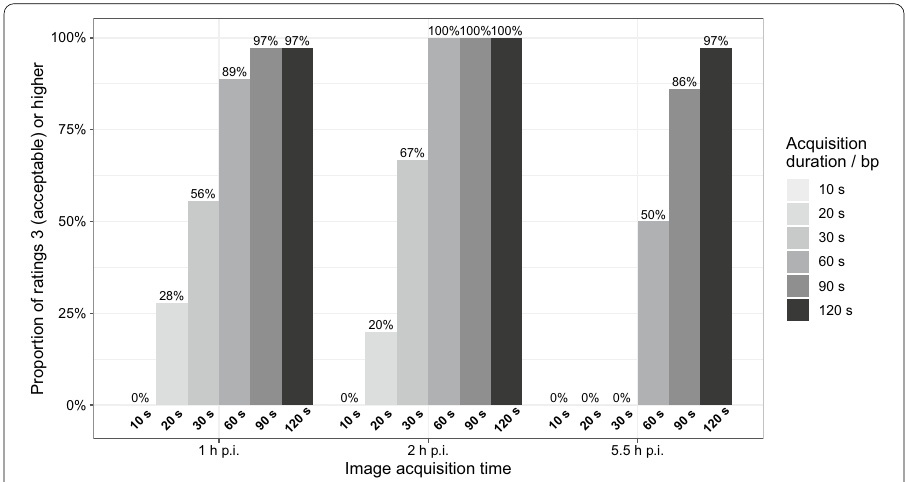
Fig. 6 Percentage of all ratings 3 (acceptable) per acquisition time p.i. and acquisition duration per bp. bp: ≥ bed position, p.i.: